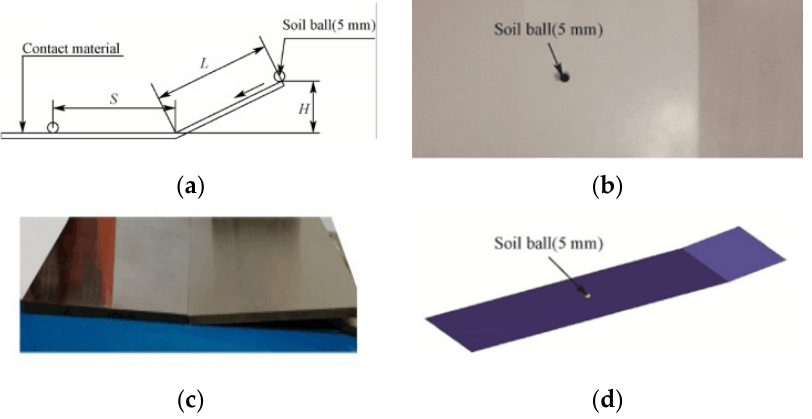
Figure 8. Slope test of soil with different contact materials. ( a ) Principle of slope test; ( b ) Slope test of 65 MNplate; ( c ) Slope test of PTFE plate; ( d ) EDEM simulation slope test [92].